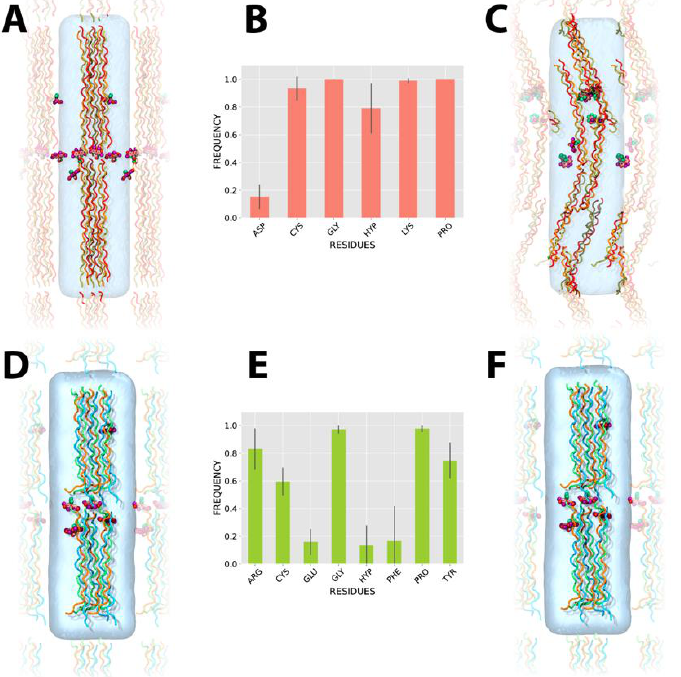
Figure 2. Three-dimensional organization of CLPI and CLPII driven by RB. ( A , D ) Initial structural configuration of a CLPI and CLPII system and RB, respectively. ( B , E ) Frequency of contact of RB with CLPI and CLPII, respectively. ( C , F ) Representative snapshot of the most probable final structural conformation of CLPI and CLPII systems stabilized by the binding of RB.